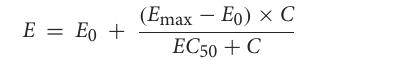
TABLE 1 The main PK parameters of tilmicosin in lung tissues of the M. gallisepticum infected